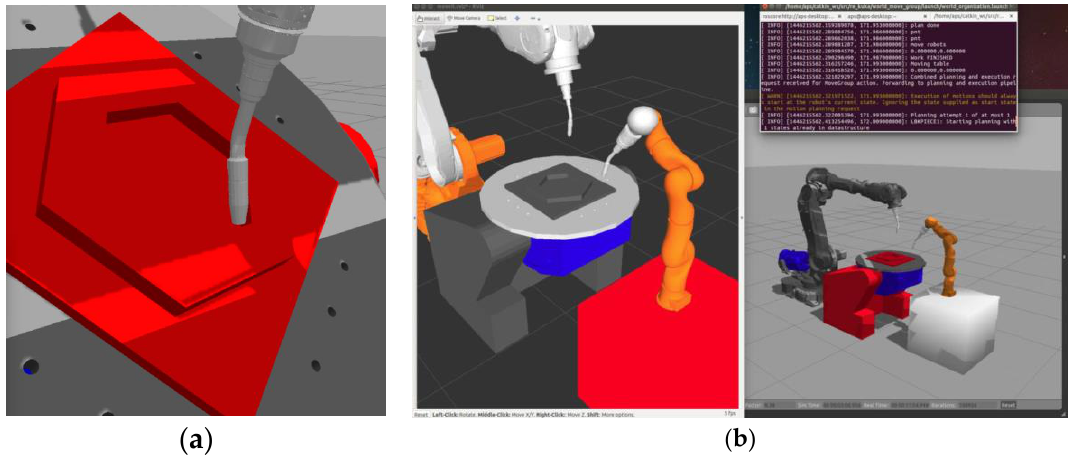
Figure 13. Welding of <piece 1> in a permanent gravity position with ABB and KUKA robots. ( a ) welding position; ( b ) loading position.